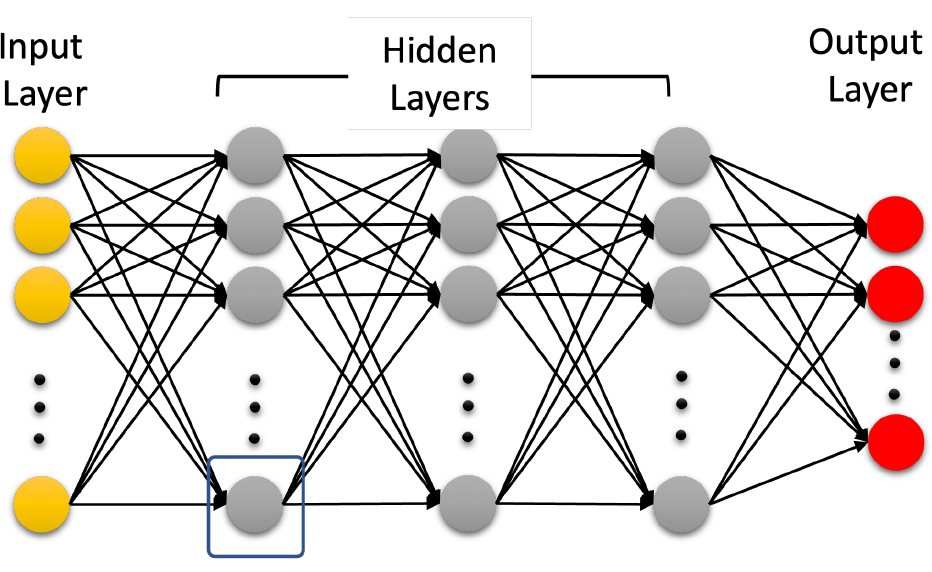
Figure 3. Deep learning neural